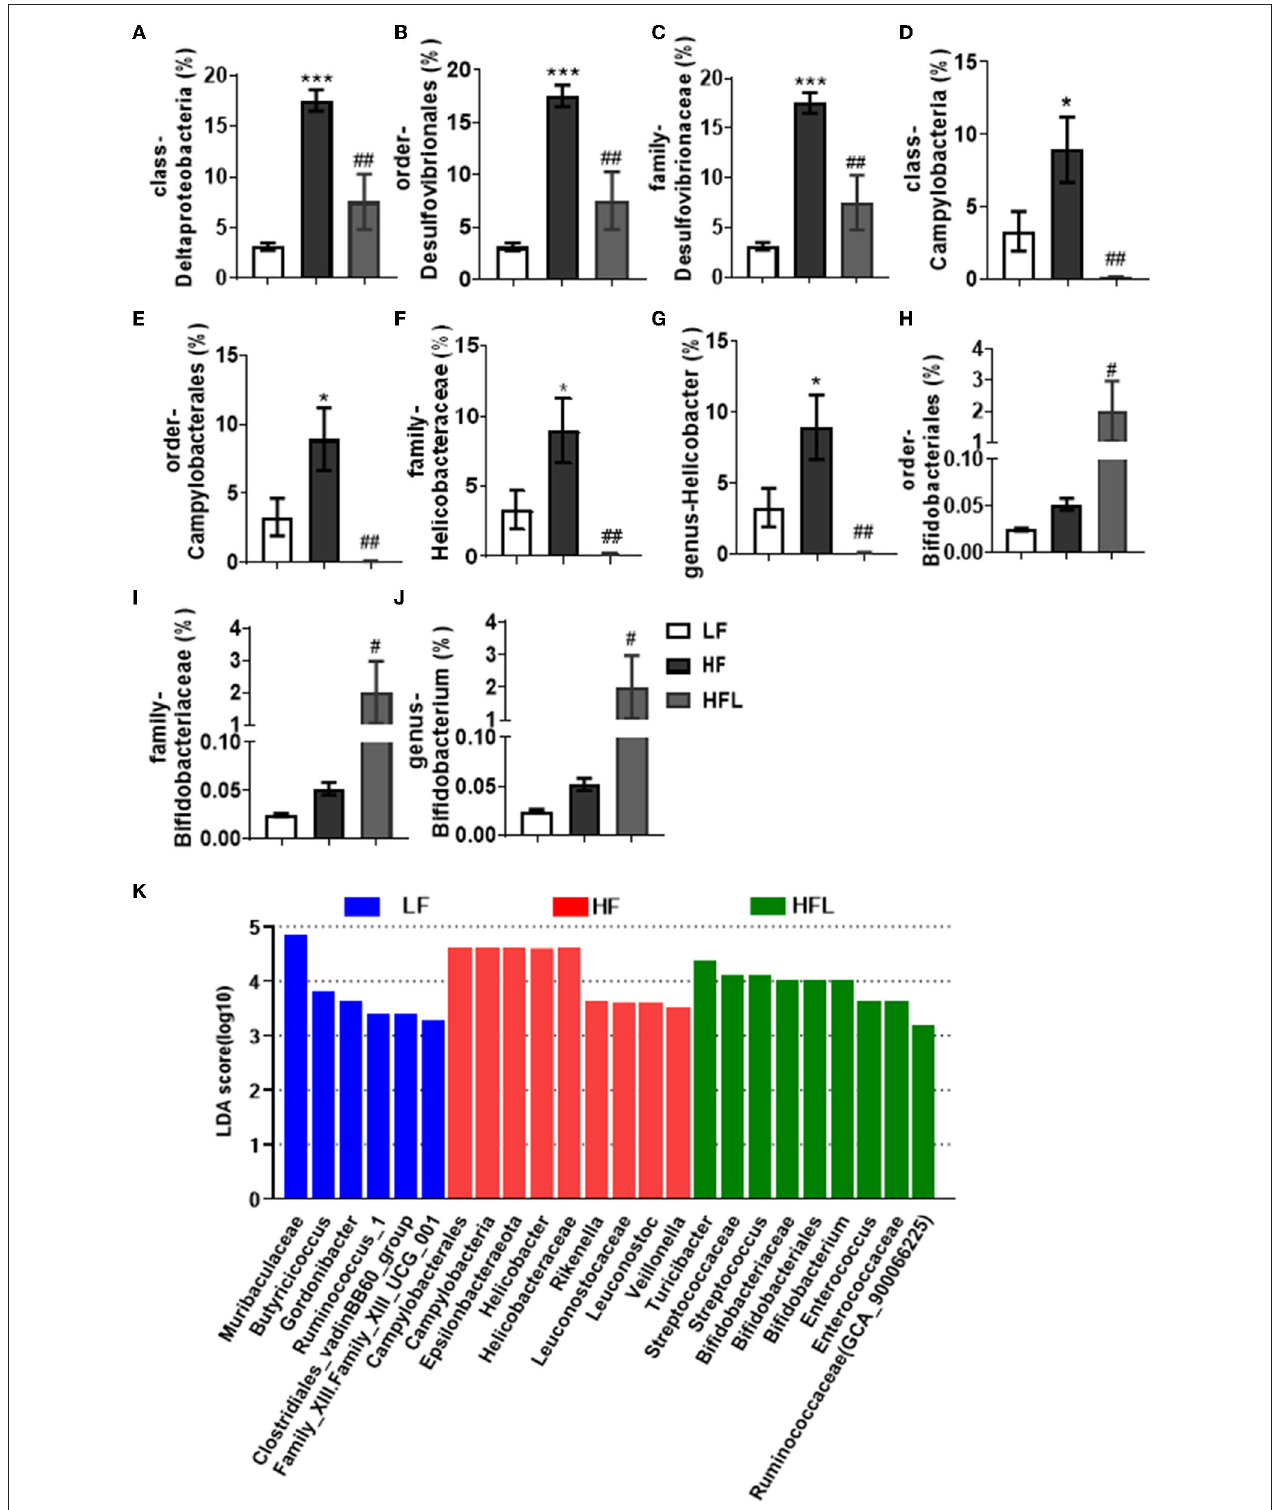
FIGURE 2 | Lentinan restored the HF-induced compositional shift of gut microbial community. (A–K) Comparison of the representative taxonomic abundance of class Deltaproteobacteria (A) , order Desulfovibrionales (B) , family Desulfovibrionaceae (C) , class Campylobacteria (D) , order Campylobacterales (E) , family Helicobacteraceae (F) , genus Helicobacter (G) , order Bifidobacteriales (H) , family Bifidobacteriaceae (I) , and genus Bifidobacterium (J) . (K) LEfSe results of mice gut microbiomes. Values are means ± SEM ( n = 6). * p < 0.05, *** p < 0.001 vs. LF mice; # p < 0.05, ## p < 0.01 vs. HF mice.